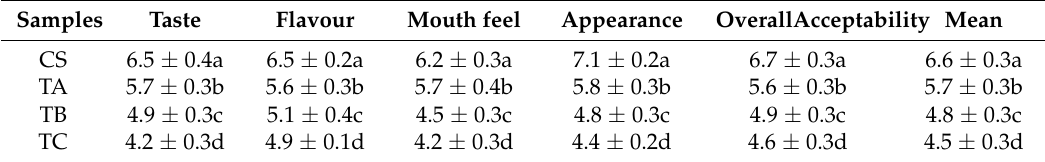
Values are means ± standard deviation of triplicate readings. Means with different alphabetical superscript in the same column are significantly different at ( p < 0.05). CS: 45% Pineapple, 40% Banana, 15% Apple; TA: 44.5% Pineapple, 39.5% Banana, 14.5% Apple, 1.5% Moringa leaves; TB: 44% Pineapple, 39% Banana, 14% Apple, 3% Moringa leaves; TC: 43.5% Pineapple, 38.5% Banana, 13.5% Apple, 4.5% Moringa leaves.